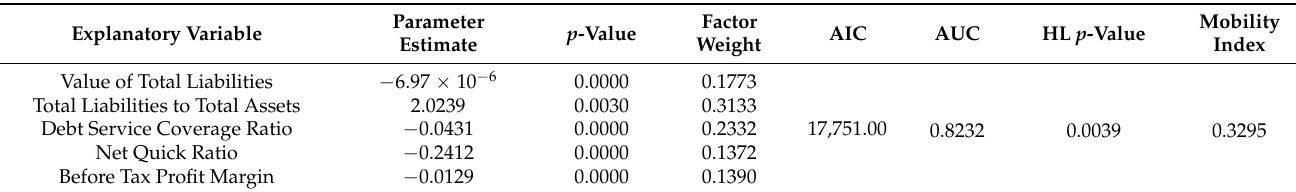
Table 10. Logistic Regression Estimation Results—Moody’s Large Corporate Financial and Macroeconomic Explanatory Variables 3-Year Default Horizon TTC Reduced Form Model 1.